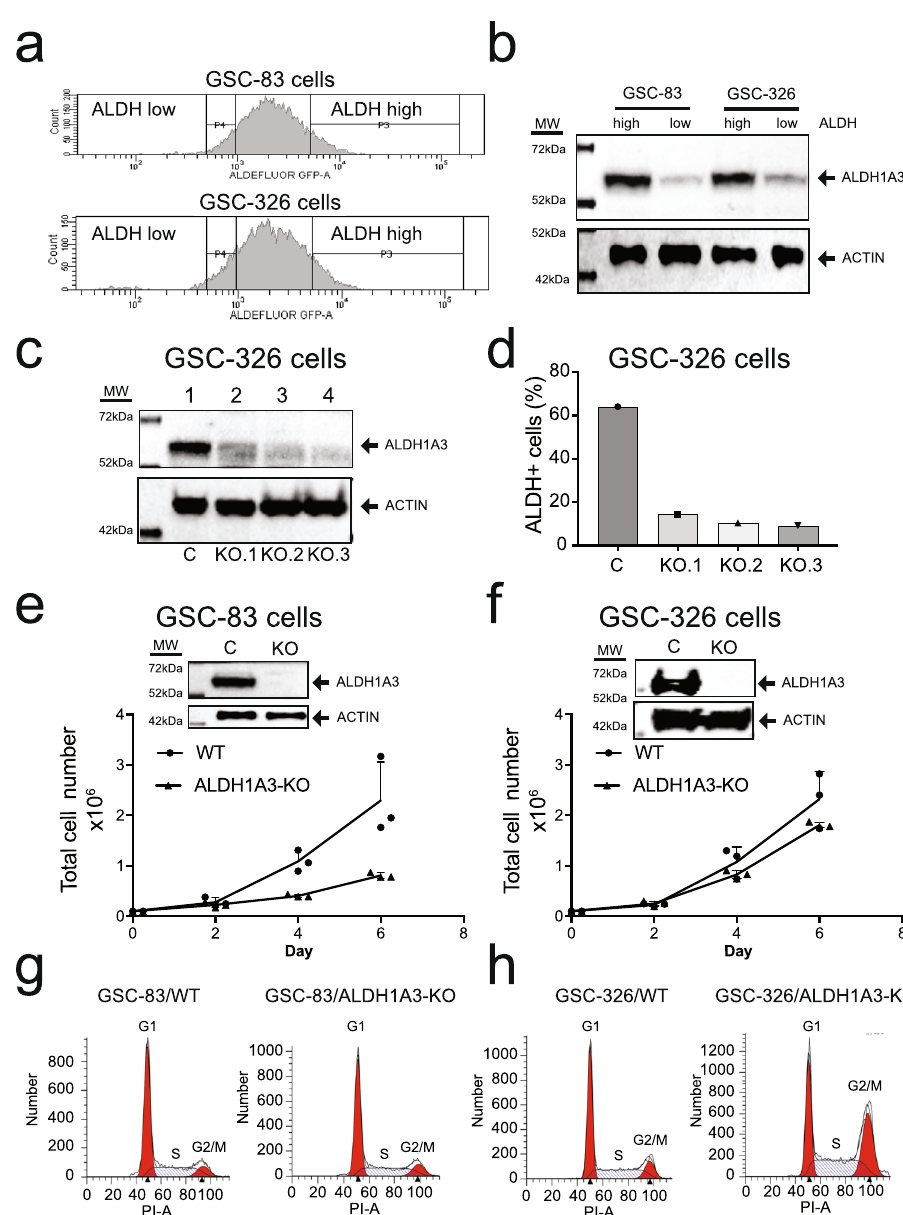
Fig. 2 ALDH1A3 and proliferation of MES glioma stem cells. a The GSC-83 and GSC-326 MES cells with the top 10% ALDH activity and bottom 10% ALDH activity were sorted via Alde fl uor FACS. b Immunoblotting analysis of ALDH1A3 protein in sorted cells with the top 10% ALDH activity and bottom 10% ALDH activity. c Immunoblotting analysis following acute depletion of ALDH1A3 (3 days after lentiviral transduction for expression of Cas9 and gRNA) in GSC-326 cells with three different guide RNAs (actin was used as the loading control). d After acute ALDH1A3 depletion, the ALDH activity of the GSC-326 cells were analyzed using the Alde fl uor assay and plotted as the percentage of ALDH1 + cells for 3 individual ALDH1A3-KO pools. e The proliferation of GSC-83/ALDH1A3-KO cells normalized to the control cells (GSC-83, n = 3 technical replicates). An immunoblot con fi rming the loss of ALDH1A3 protein expression in the GSC-83/ALDH1A3-KO cells is shown in the inset. f The proliferation of GSC-326/ALDH1A3-KO cells normalized to the control cells (GSC-326, n = 3 technical replicates). An immunoblot con fi rming the loss of ALDH1A3 protein expression in the GSC-326/ALDH1A3-KO cells is shown in the inset. g Cell cycle analysis of GSC-83 (WT) and GSC-83/ALDH1A3-KO cells. h Cell cycle analysis of GSC-326 (WT) and GSC-326/ ALDH1A3-KO